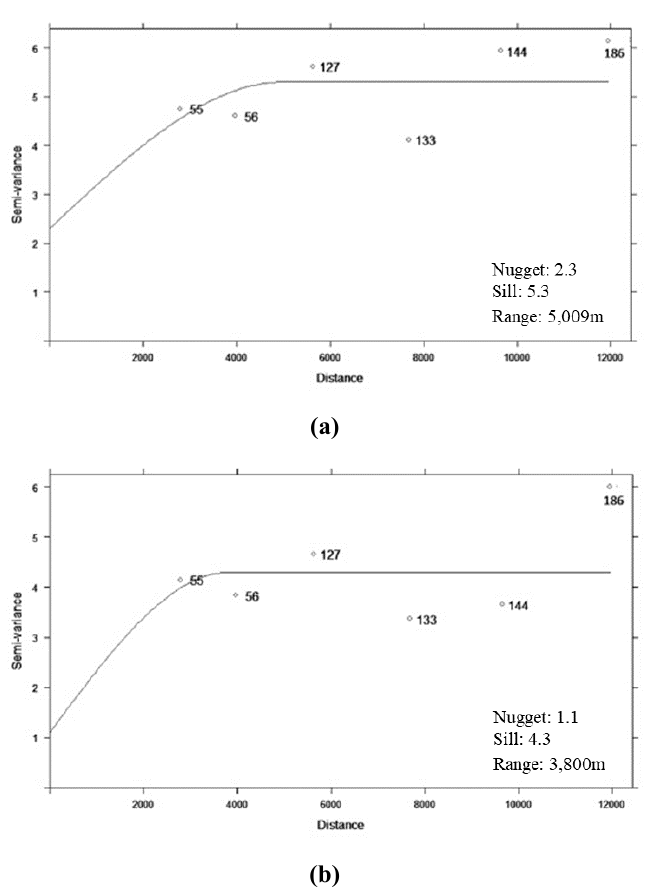
Figure 8. Experimental variogram and fitted variogram model with the 50 GCP dataset: ( a ) error X; ( b ) error Y.